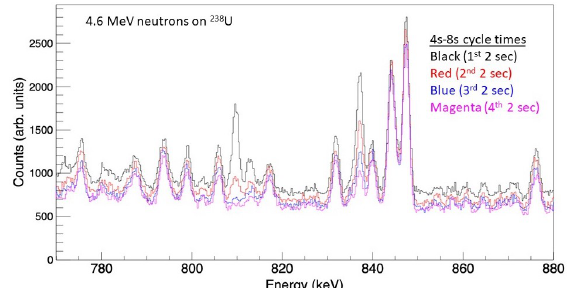
Figure 4. Preliminary data showing the presence of short-lived fission products for a 4 s irradiation / 8 s measurement cycle.